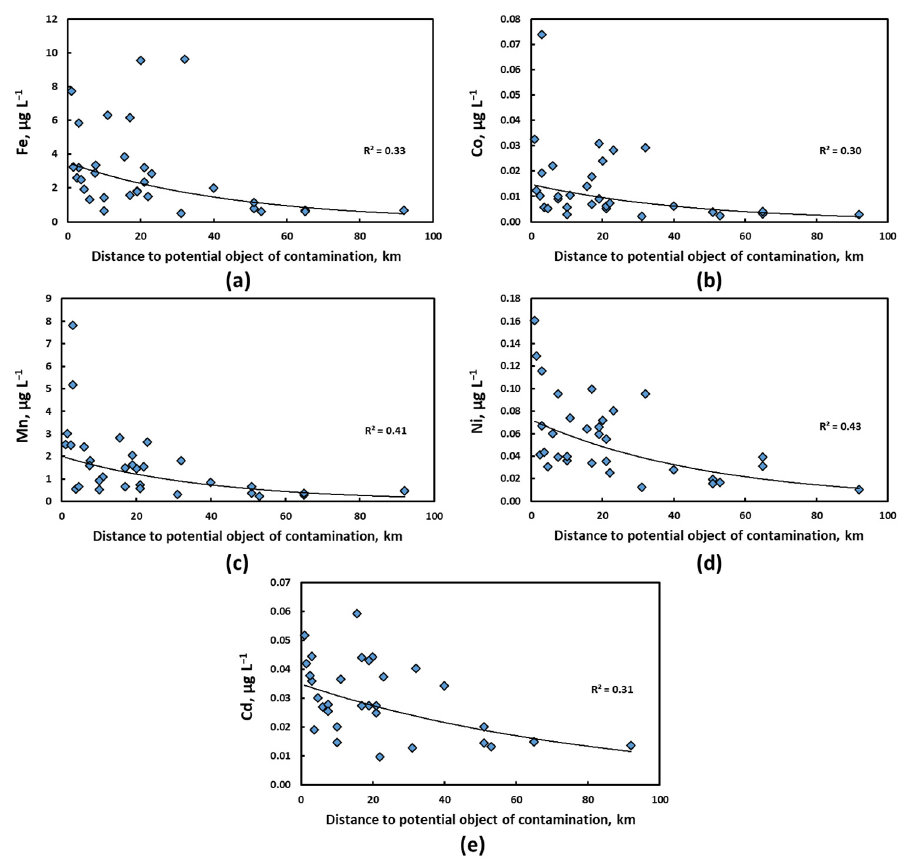
Figure 4. Examples of dissolved (<0.22 µm) metal concentrations in snow water as a function of distance to potential object of contamination in the WSL. Fe ( a ); Co ( b ); Mn ( c );Ni ( d ); Cd ( e ).